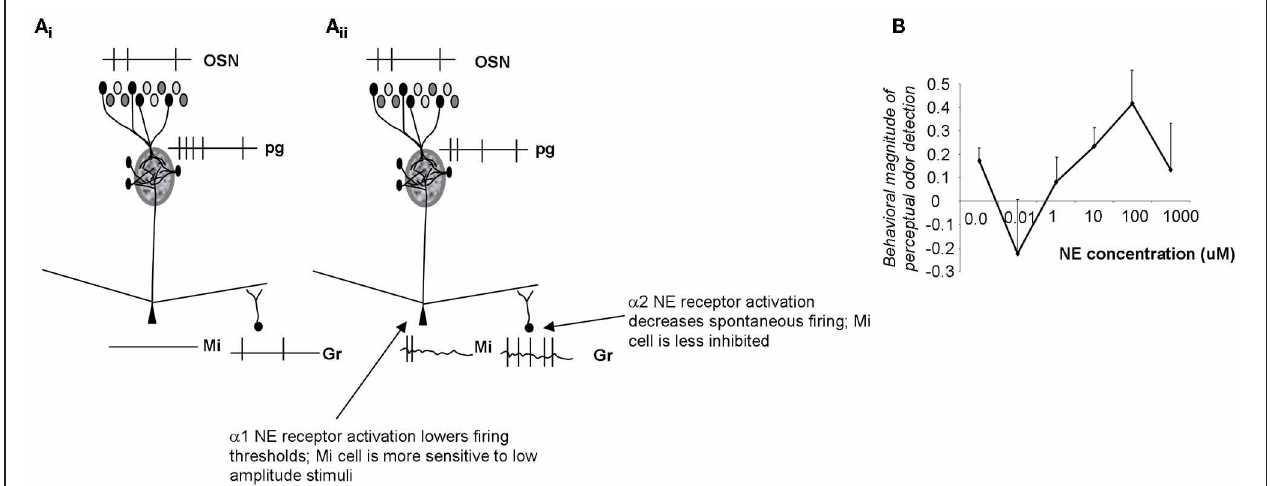
FIGURE 4 | Schematic depiction of noradrenergic modulation of odor sensitivity. (A i ) OSN inputs are processed in the glomerular layer and result in activation of a subpopulation of mitral cells. The spiking response of these active cells is further influenced by inhibitory inputs from granule cells. In the example shown here the applied stimulus was below threshold in amplitude, resulting in no spiking response in mitral cells. (A ii ) NE α 2 activation (at very low NE concentrations) decreases granule cell spontaneous activity, and disinhibits mitral cells (Nai et al., 2009, 2010). Mitral cells are more responsive to odorants and to low amplitude electrical stimulation (Jiang et al., 1996; Ciombor et al., 1999). At higher NE concentrations, α 1 receptors are activated, granule cell spontaneous